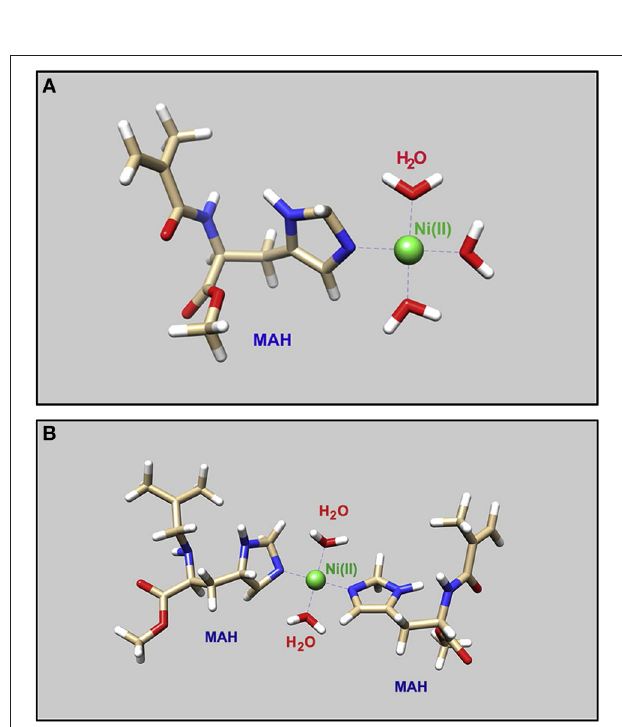
FIGURE 3 | (A) Geometrical optimization of the molecular structure of (1:1) molar ratio for MAH-Ni(II) pre-complexes and (B) (2:1) molar ratio (Tamahkar et al.,